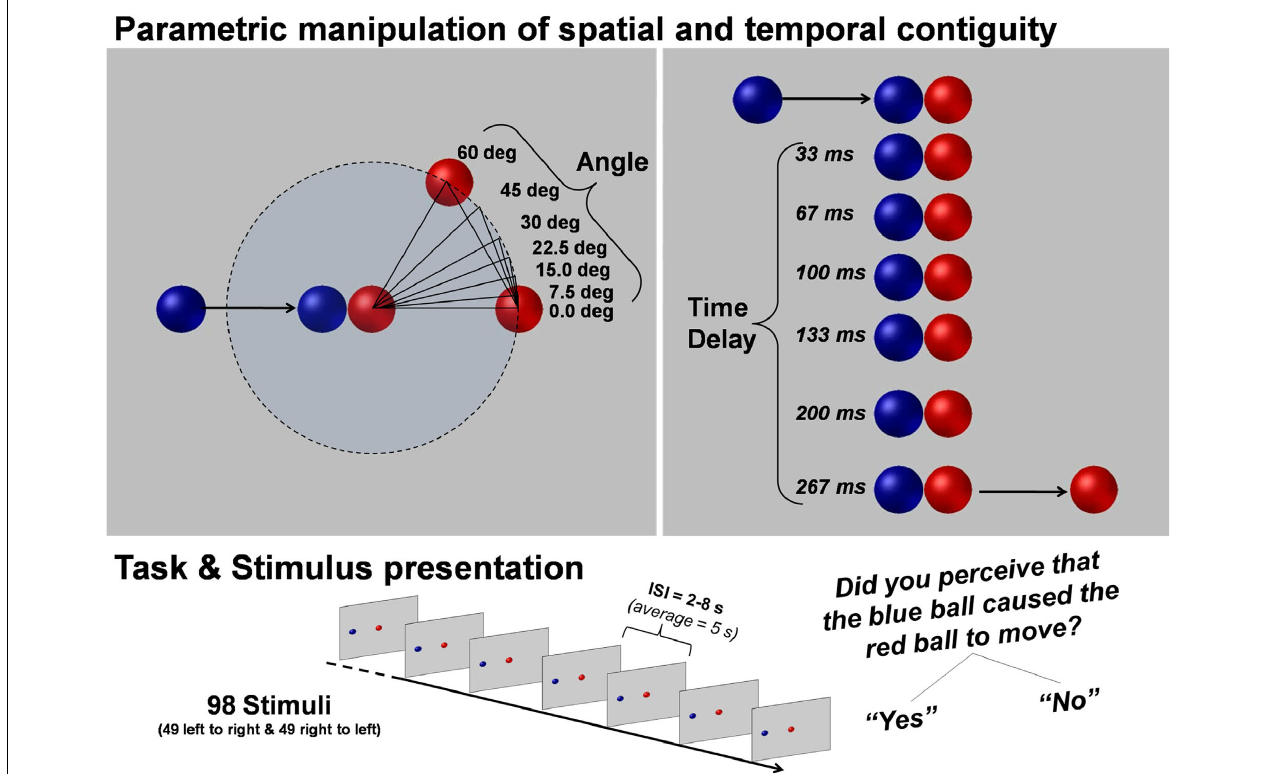
FIGURE 1 | Parametric manipulation of spatial continuity and temporal contiguity. Illustrates the parametric violations of spatial continuity and temporal contiguity. All combinations of angle and time delay were presented to the subjects